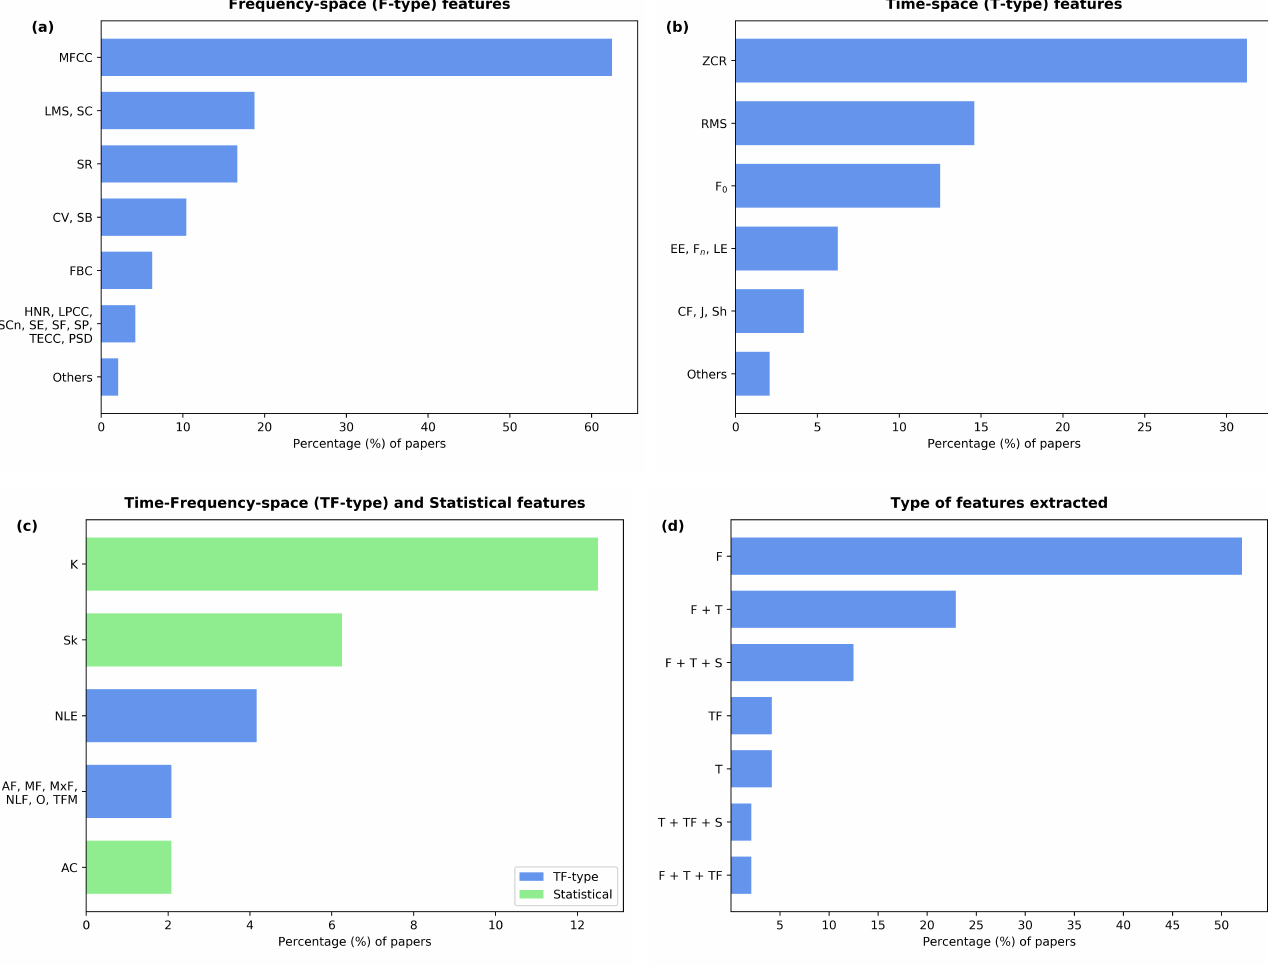
Figure 4. Percentage of papers that extracted each listed feature grouped according to feature types: F-type ( a ), T-type ( b ), and TF-type and S-type ( c ). Additionally, the percentage of papers using each of the given combinations of feature types is shown ( d ). Legend ⇒ Mel-Frequency Cepstral Coefficients (MFCC), Log-Mel Spectrogram (LMS), Chroma Vector (CV), Spectral Centroid (SC), Spectral Roll- off (SR), Spectral Bandwidth (SB), Filter Bank Coefficients (FBC), Harmonics-to-Noise Ratio (HNR), Linear-Predictive Coding Coefficients (LPCC), Spectral Contrast (SCn), Spectral Entropy (SE), Spectral Flux (SF), Spectral flatness (SP), Teager Energy Cepstral Coefficients (TECC), Power Spectrum Density (PSD), Zero Crossing Rate (ZCR), Root-Mean-Square (RMS), fundamental Frequency (F 0 ), Entropy of the Energy (EE), formant Frequencies (F n ), Log Energy (LE), Crest Factor (CF), Jitter (J), Shimmer (Sh), Kurtosis (K), Skewness (Sk), Non-Linear Entropies (NLE), Average, Mean and Maximum Frequency (AF, MF, and MxF), Non-Linear Features (NLF), Onset (O), Time-Frequency Moment (TFM), and AutoCorrelation